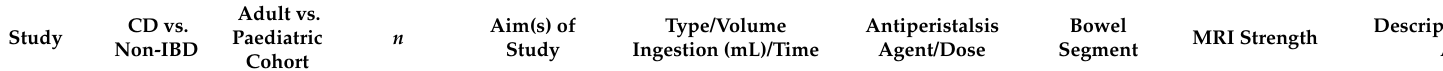
Table 1. Summary of MR enterography studies describing motion